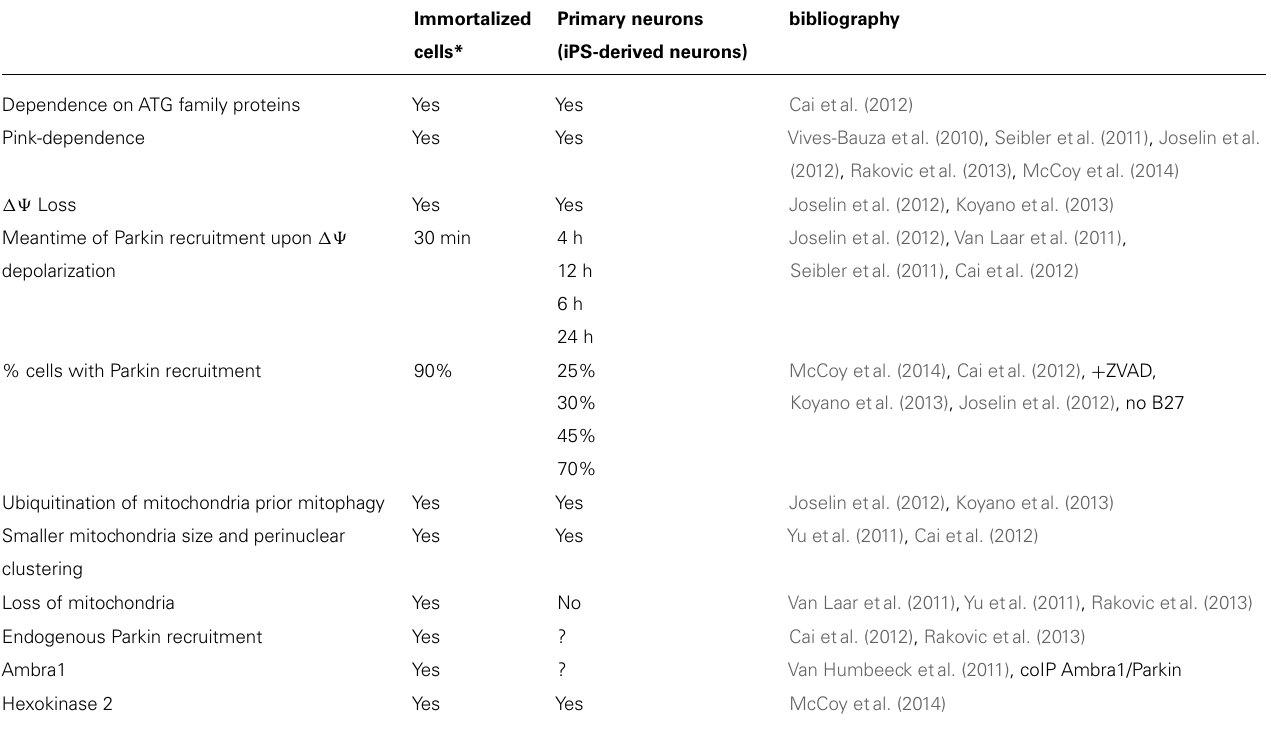
Table 1 | Comparison of Pink–Parkin pathway between immortalized cells and post-mitotic neurons.